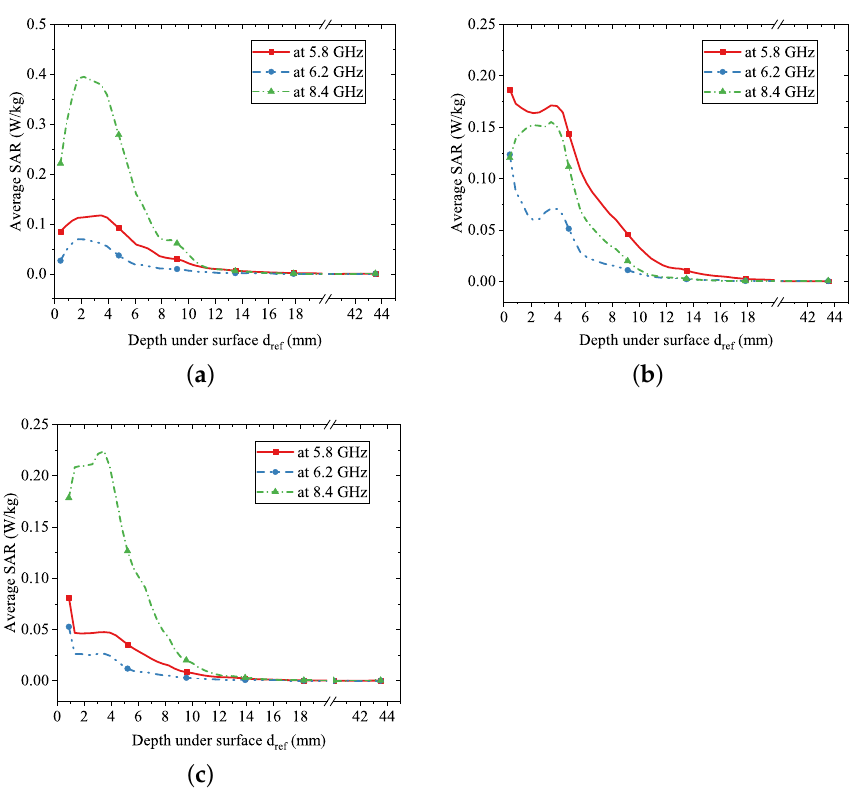
Figure 26. Average SAR vs. d ref along the reference line. ( a ) SAR on reference line for d ant = 20 mm; ( b ) SAR on reference line for d ant = 30 mm; and ( c ) SAR on reference line for d ant = 40